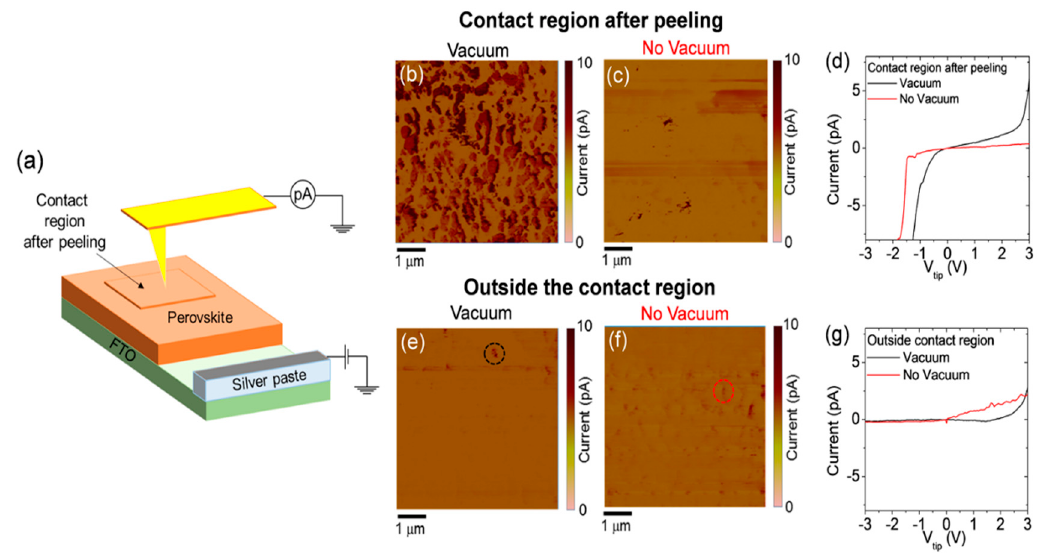
Figure 4. Conductive atomic force microscopy (CAFM) measurements: ( a ) Schematic of conductive atomic force microscopy (CAFM) measurements; Current maps ( b ), ( c ) and local intensity current-voltage (I-V) measurements ( d ) in the region of the contact after peeling for DBv-PSCand for DB-PSC. Current maps ( e ), ( f ) and local I-V measurements, in the areas indicated by black (DBv-PSC) and red (DB-PSC) circles, outside the contact region ( g ).The maps are taken at a fixed voltage of 3 V.